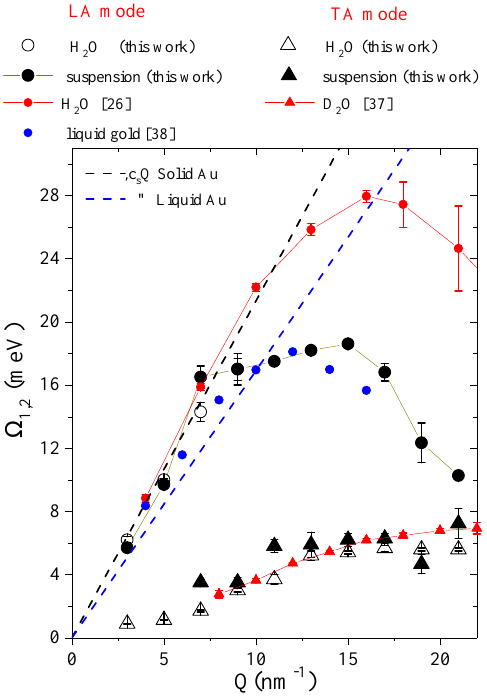
Figure 3. The dispersion curves derived through the best fit values of the DHO frequencies Ω 1,2 for the Au-NP suspension and pure water are compared with the low and high energy dispersion branches of heavy water [37], customarily ascribed to a transverse acoustic (TA) and longitudinal acoustic (LA) modes, as well as with the (LA) branch of liquid gold [38]. The meaning of the various symbols are specified in the